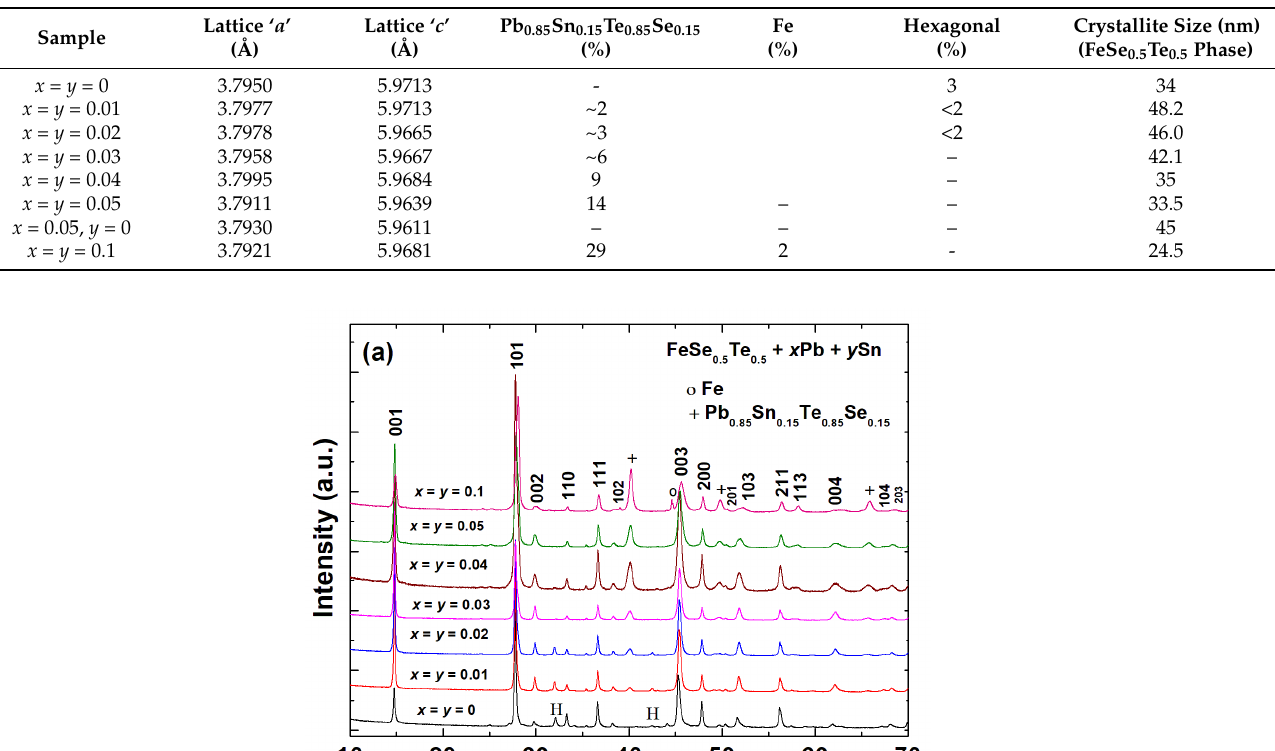
Table 1. The obtained lattice parameters ‘ a ’ and ‘ c ’, the impurity phases, and the crystallite size of the main tetragonal phase for FeSe 0.5 Te 0.5 + x Pb + y Sn samples are listed. We used Rigaku’s PDXL software and the ICDD PDF4 + 2021 standard diffraction patterns database for the quantitative analysis of impurity phases (%) and crystallite size through the refinement of the measured XRD data.